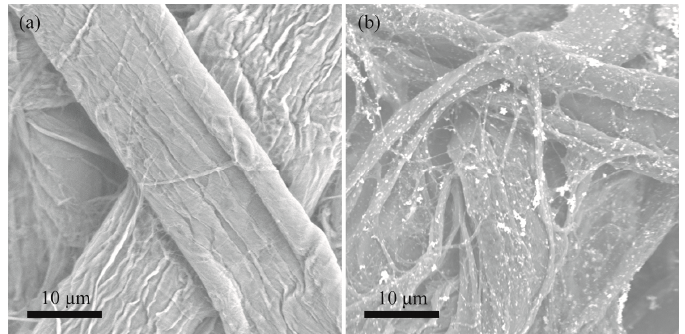
Figure 1. Scanning electron microscopy (SEM) images of the ( a ) iron/palladium (Fe/Pd)-free and ( b ) Fe/Pd nanoparticle (NP)-assembled filter paper.